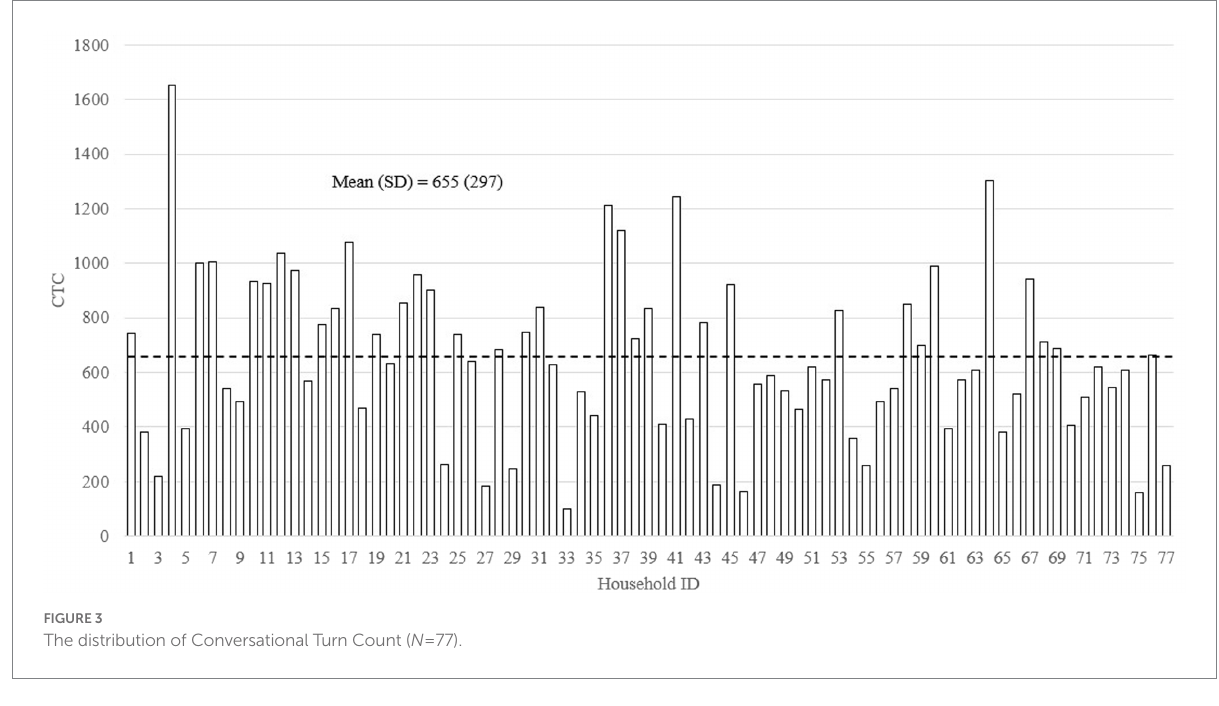
FIGURE 3 The distribution of Conversational Turn Count ( N =